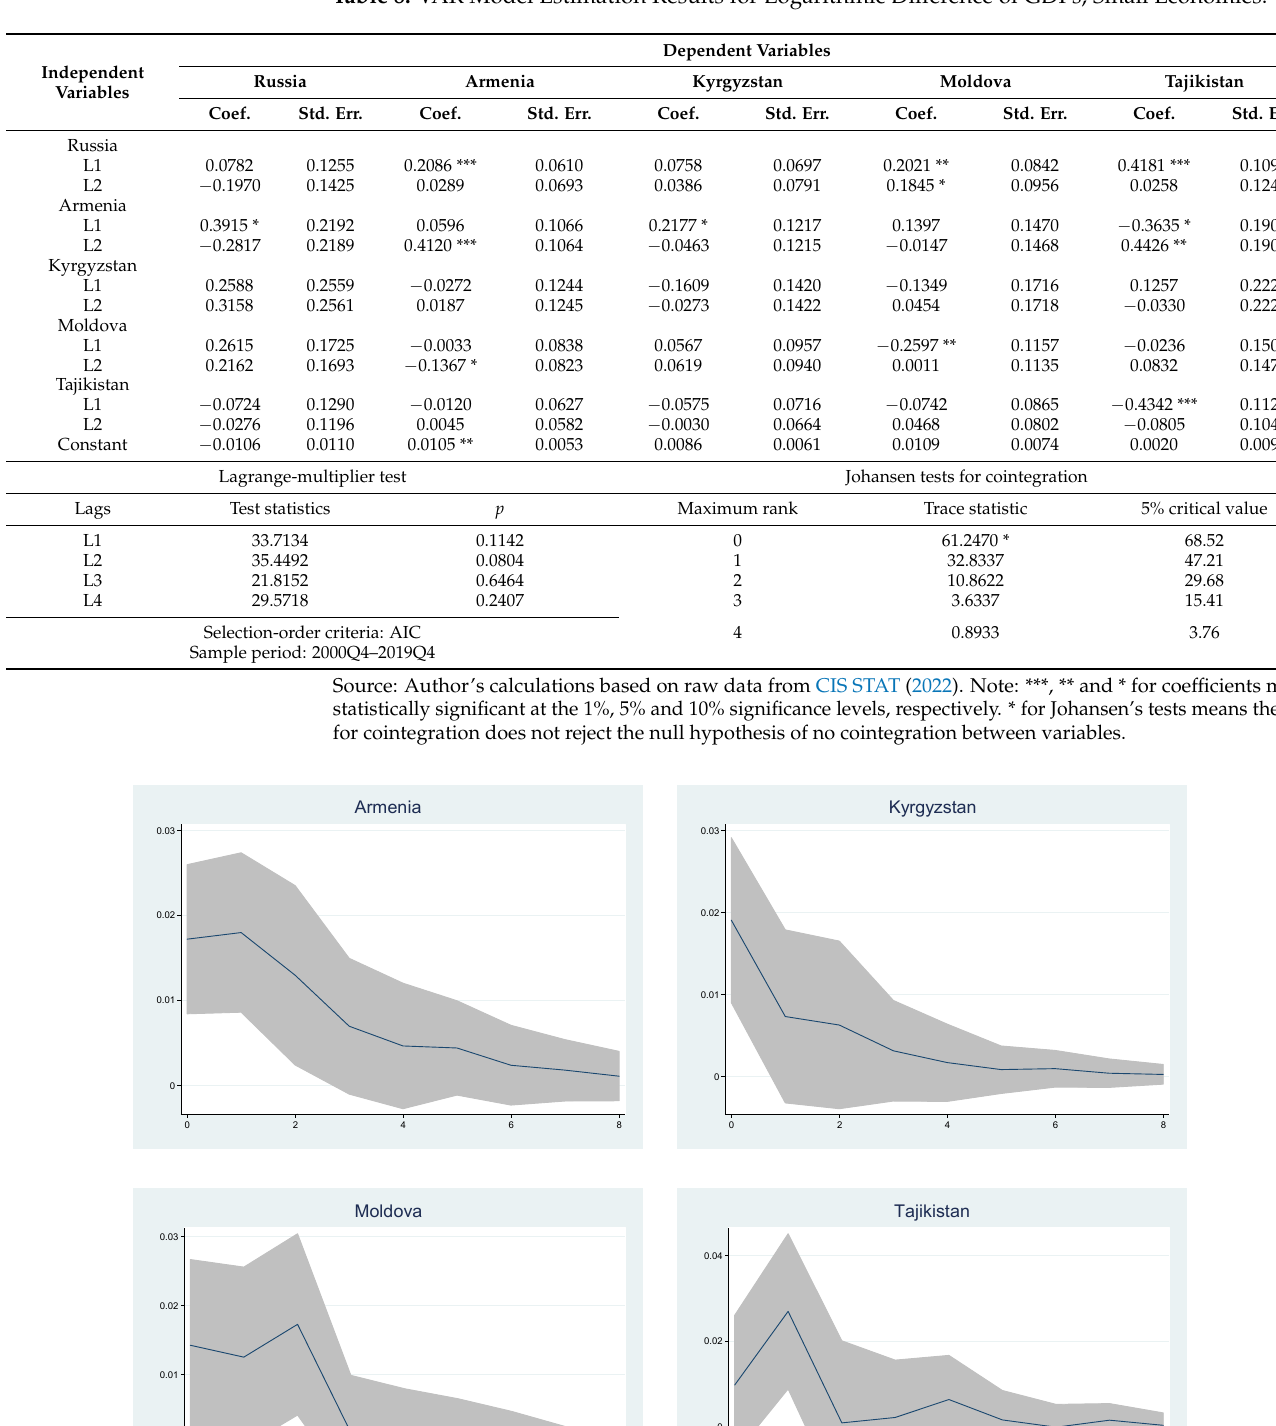
Table 8. VAR Model Estimation Results for Logarithmic Difference of GDPs, Small Economies.